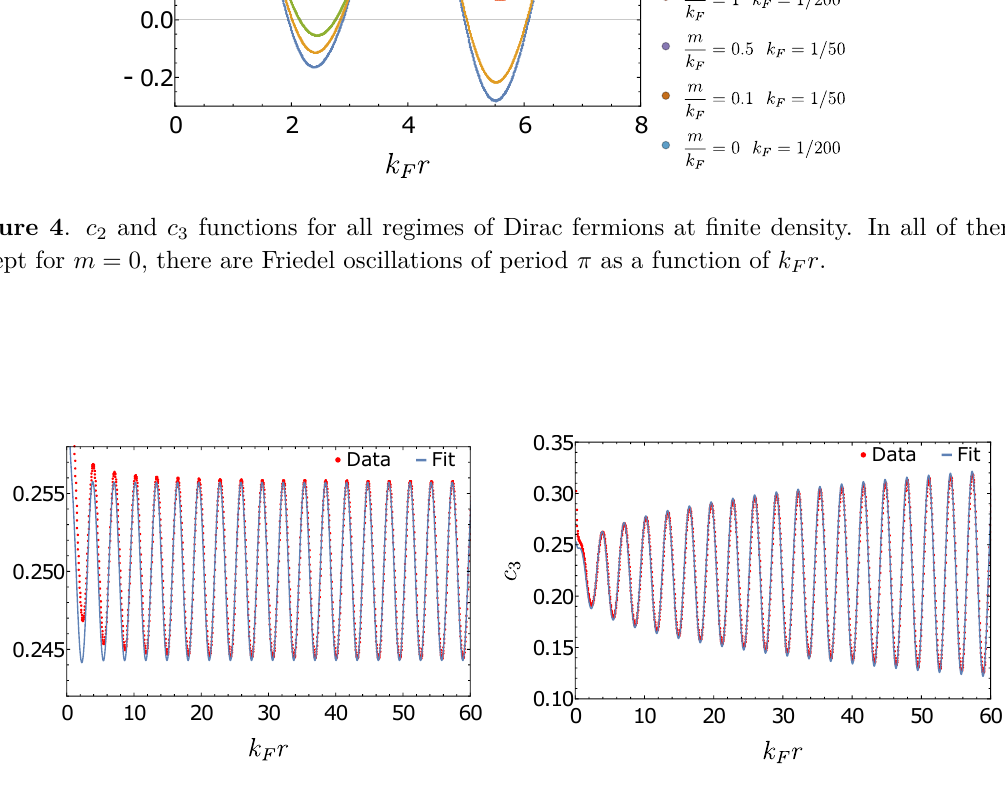
Figure 5 . Fits of c 2 and c 3 for m/k F = 0 . 1 with k F = 1 / 50 . The fits were used following the expression (4.2) and c n ( r ) = rS 0 ( r ) . The free parameter of every fit is the amplitude A n